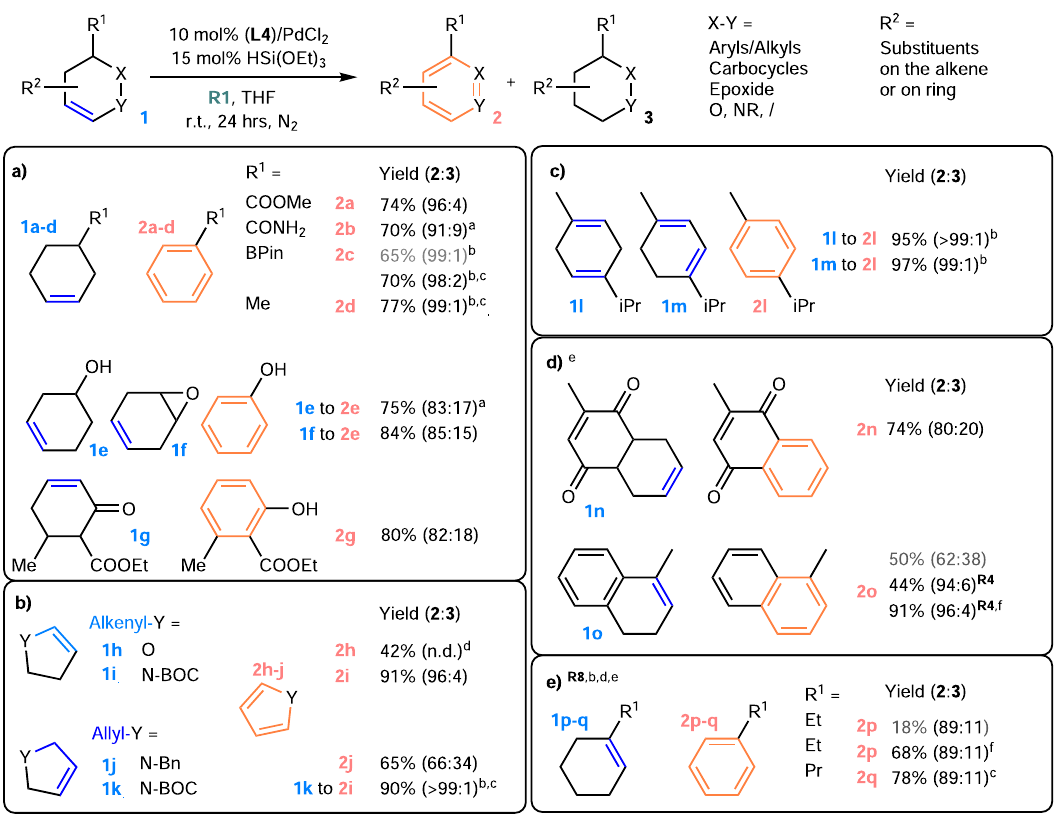
Fig. 4 | Endocyclic ole fi n 1 transfer-dehydroaromatization. a Cyclohexenes. b Heterosubstituted rings. c Dienes. d Fused rings. e Trisubstituted alkenes. Stan- dardconditions:Theole fi n(0.25mmol), L4 /PdCl 2 catalyst(0.025mmol),HSi(OEt) 3 (0.0375mmol), and R1 (0.5mmol) were stirred in 2mL of THF for 24hrs at r.t. except if otherwise indicated. The yields of 2 and 2 : 3 (shown in parentheses) were